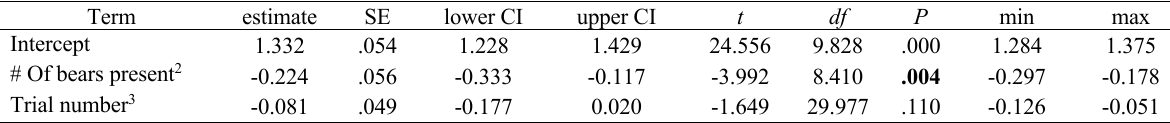
Note. 1 Results displayed are estimates and standard errors, together with confidence limits, results of tests, and the range of estimates obtained when dropping levels of random effects one at a time, 2 z -transformed to a mean of 0 and a standard deviation of 1; mean and SD of the original variable were .446 and .23, respectively, and 3 z -transformed to a mean of 0 and a standard deviation of 1; mean and SD of the original variable were .382 and .315,